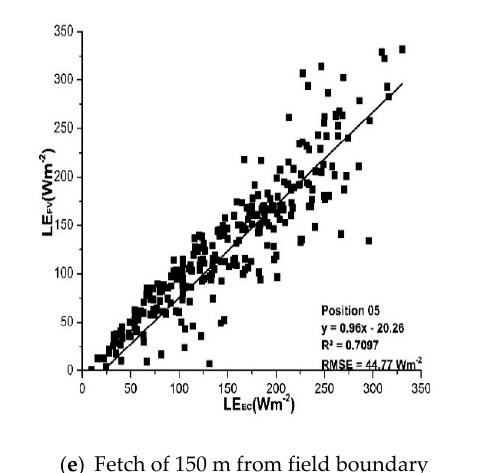
Figure 8. ( a ) Fetch of 170 m from field boundary; ( b ) Fetch of 165 m from field boundary; ( c ) Fetch of 160 m from field boundary; ( d ) Fetch of 155 m from field boundary; ( e ) Fetch of 150 m from field boundary. Half-hourly LE FV derived by using Equation (12) plotted against LE EC for unstable conditions during Sep–Nov